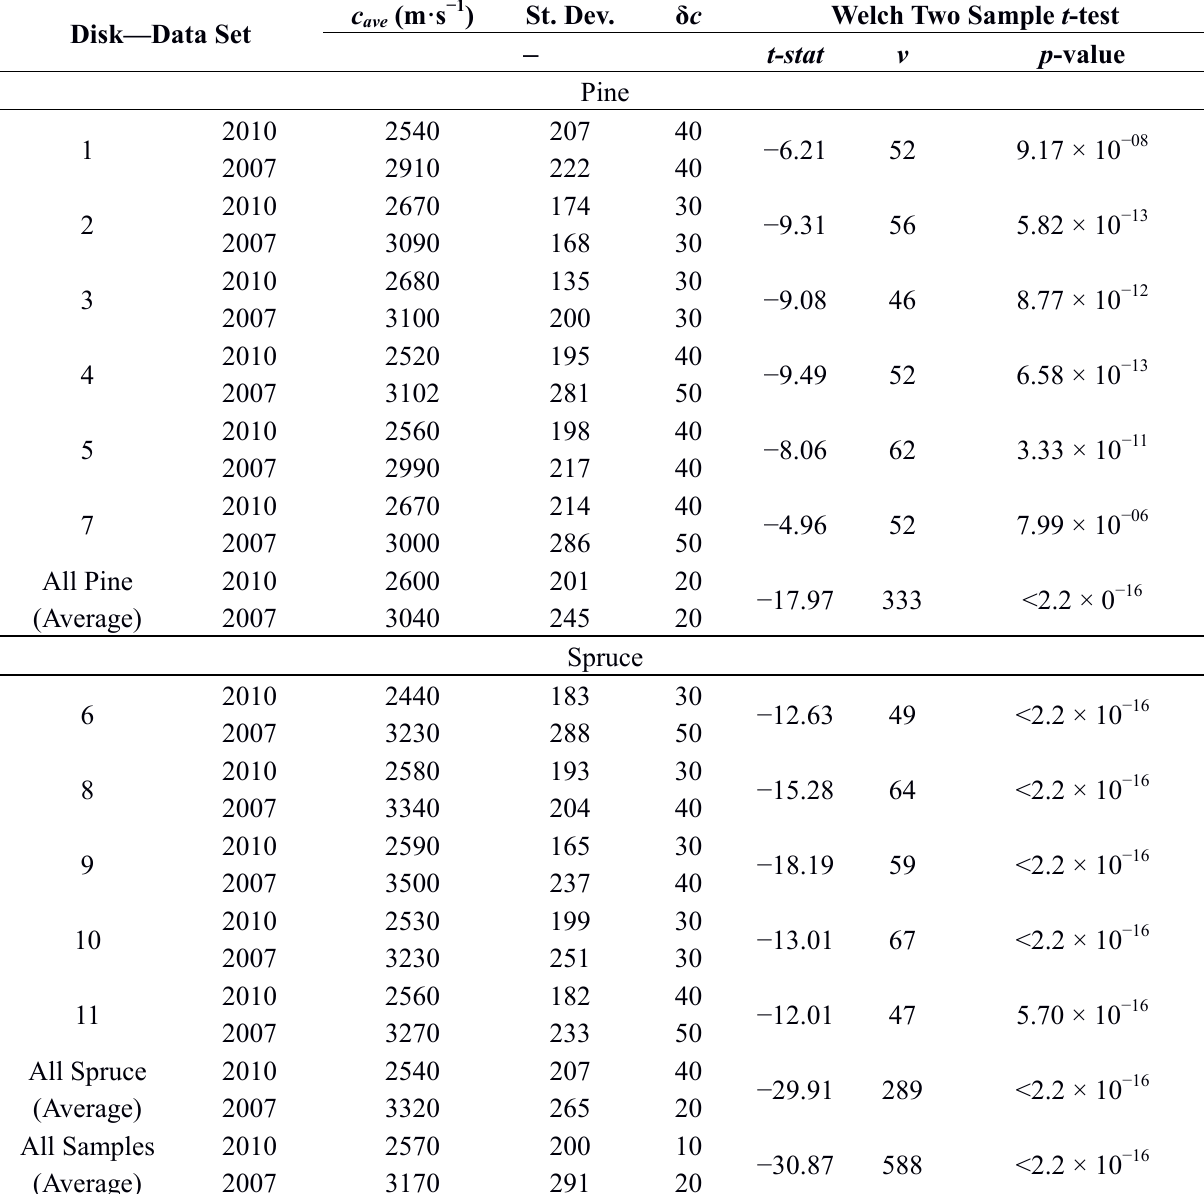
Table 1. Results for speed of sound